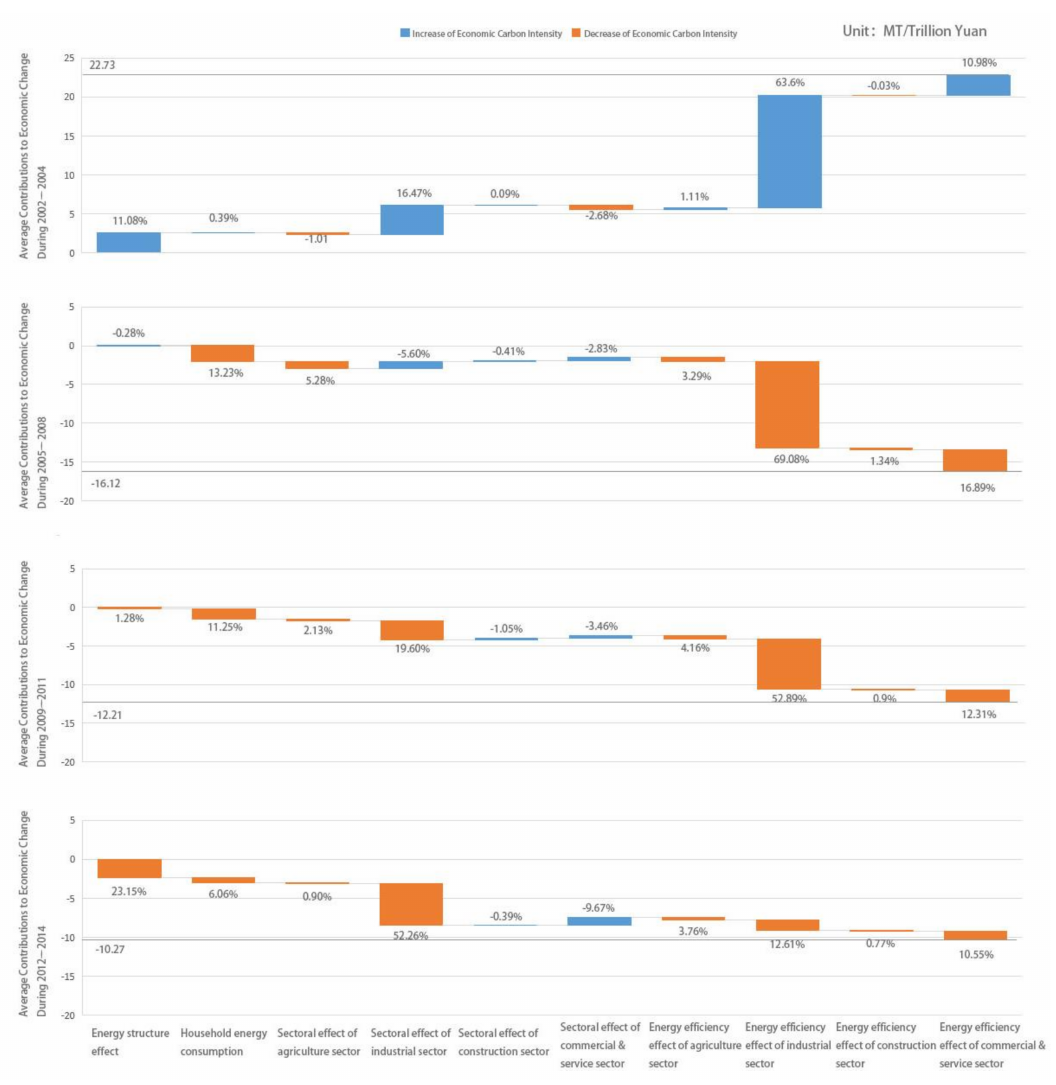
Figure 10. The characteristics and differences of various carbon emission